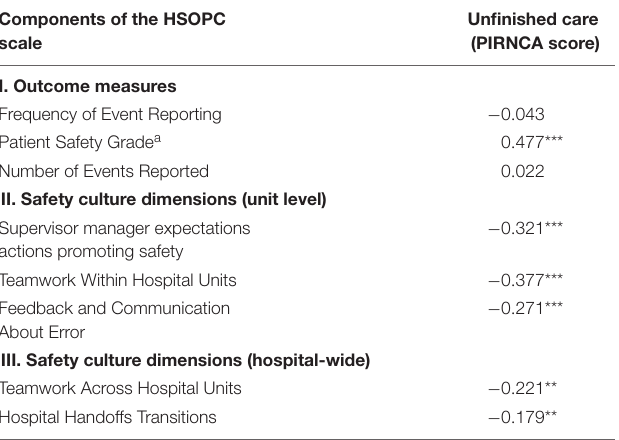
TABLE 3 | The relationships between Unfinished care (PIRNCA score) and Patient Safety Culture (components of HSOPSC scale). Components of the HSOPC